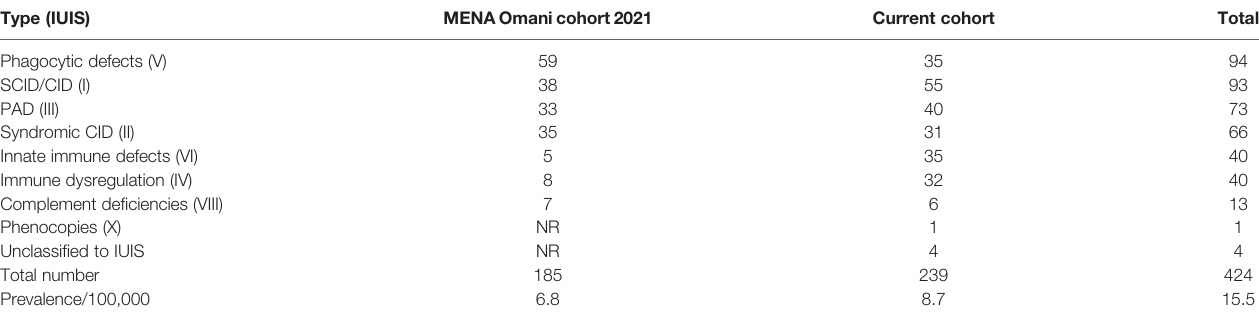
TABLE 1 | Combined data showing the prevalence of IEI in Omani patients according to IUIS classi fi cation. Type